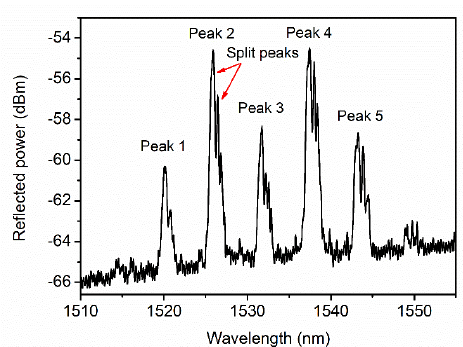
Figure 3. Reflected spectrum of the 4 mm-long FBG inscribed with a pulse energy of 10.15 nJ in the second regime.